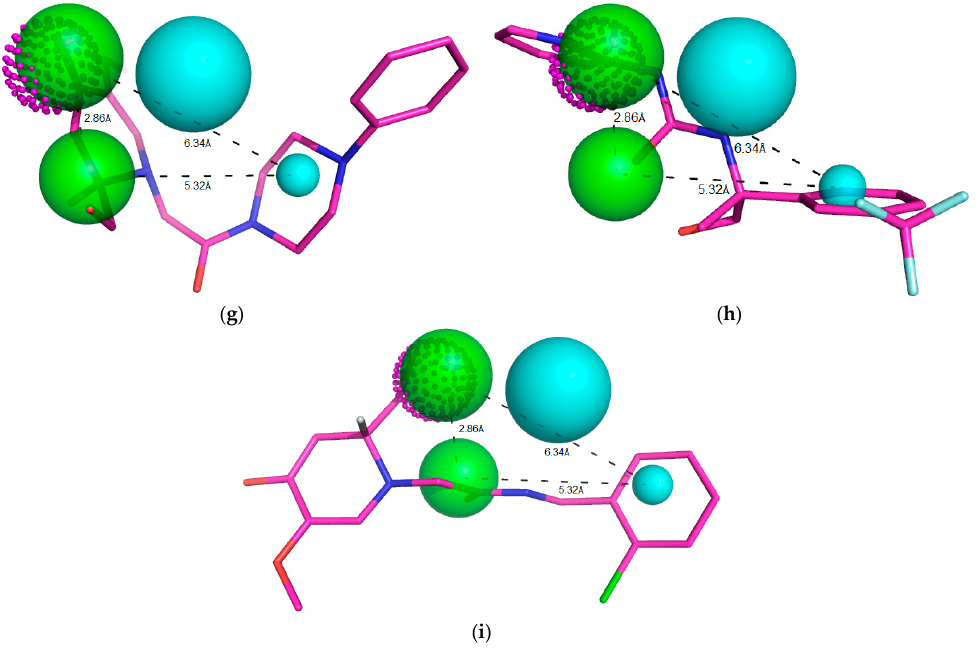
Figure 10. Representation of the ten compounds that fit to the pharmacophoric model, with QFIT > 0. Green beads/spheres represent H-bond acceptor groups, magenta dotted spheres represent H-bond donor groups, while hydrophobic centers are shown in cyan spheres. Size of the beads varies according to the tolerance radius calculated using GALAHAD. All the distances are measured in angstroms ( a ) ZINC91881108 ; ( b ) ZINC81021663 ; ( c ) ZINC89571615 ; ( d ) ZINC69349687 ; ( e ) ZINC12230819 ; ( f ) ZINC69349685 ; ( g ) ZINC12230756 ; ( h ) ZINC69431616 and ( i ) ZINC12230826 .